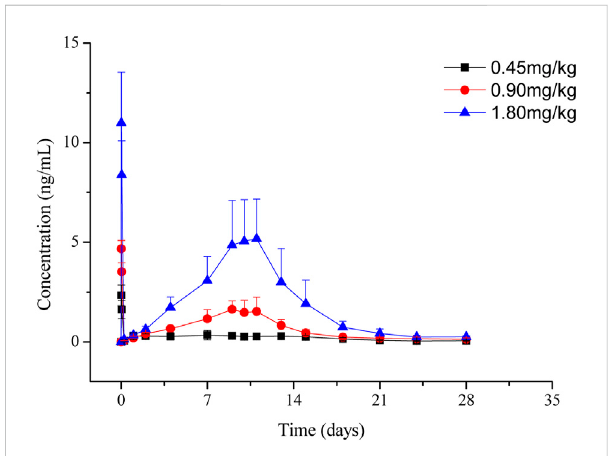
FIGURE 3 Mean plasma concentration-time pro fi les of LY01005 after intramuscular injections of 0.45, 0.90 and 1.80 mg/kg (peptide base) in rats.